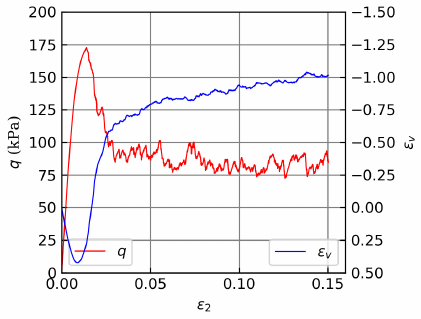
Figure 2. The evolution of deviatoric stress and volumetric strain with respect to the axial strain